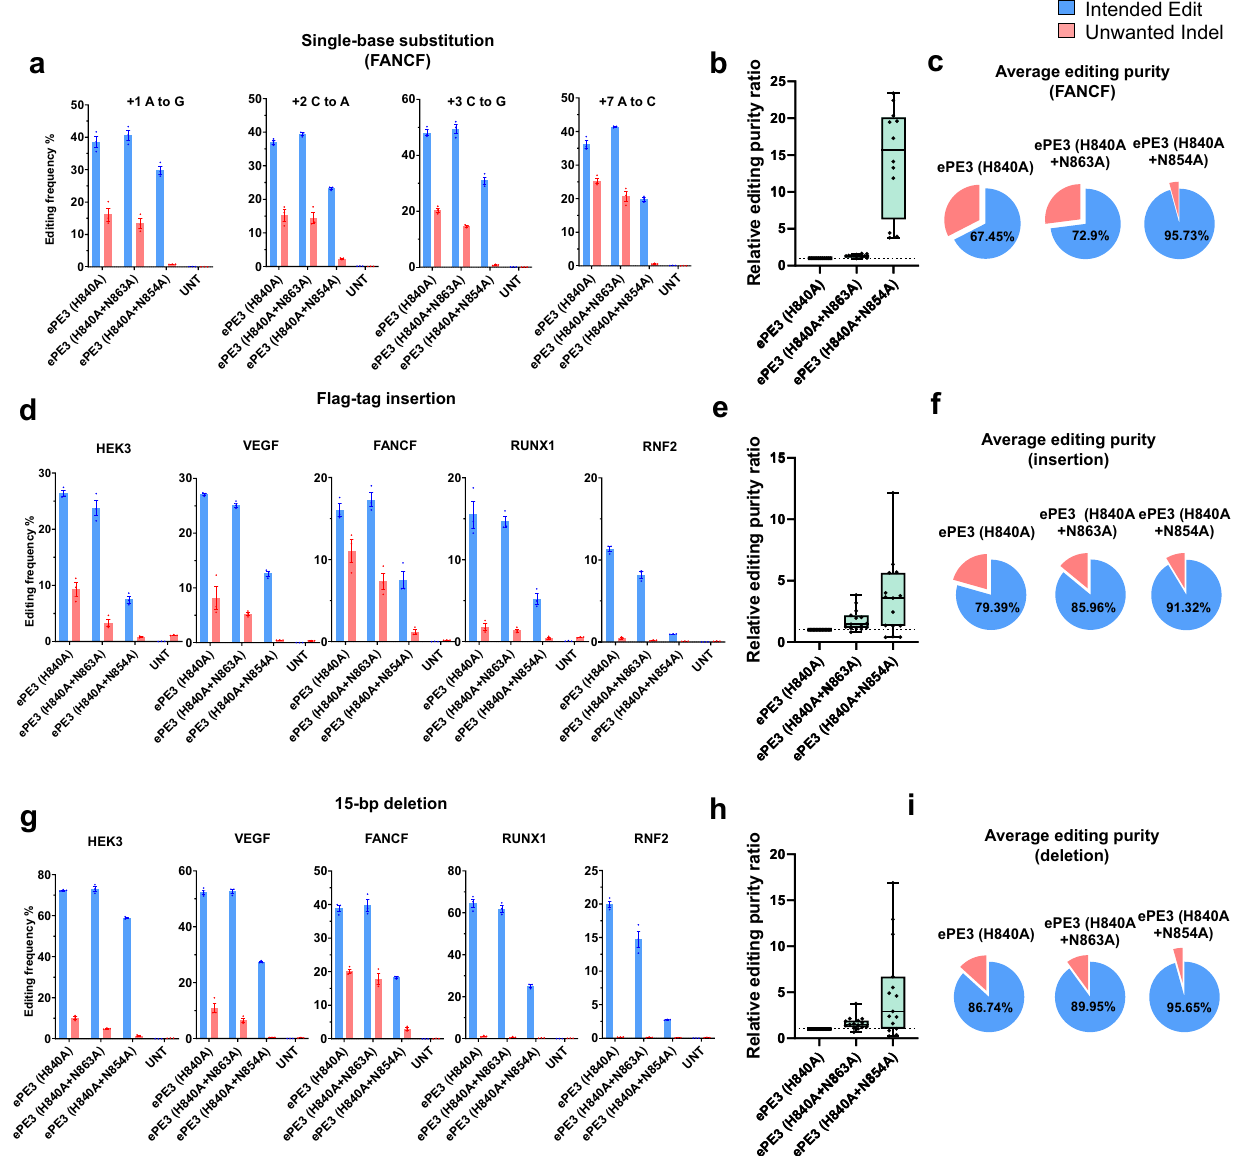
Fig. 5 | epegRNAs used together with PE variants that incorporate nCas9 (H840A+N863A) and nCas9 (H840A+N854A) increase the purity of the cor- rect edit for the PE3 system. a Plasmids encoding PE (nCas9 variants), epegRNAs encoding four different single-base substitutions targeted to the FANCF site, and nickingsgRNAsweretransfectedintoHEK293Tcells. b Relativeeditingpurityratios (the frequency of correct edits normalized to that induced by ePE3 (H840A) / the frequencyofunwantedindelsnormalizedtothatinducedbyePE3(H840A))forthe foursingle-basesubstitutions. c ,TheaverageeditingpuritiesassociatedwiththePE (nCas9 variants) shown in pie charts. d – i Plasmids encoding PE (nCas9 variants), epegRNAs encoding 24-bp Flag-taginsertions( d )or15-bpdeletions ( g )targetedto fi ve different sites ( HEK3 , VEGFA , FANCF , RUNX1 , and RNF2 ), and nicking sgRNAs